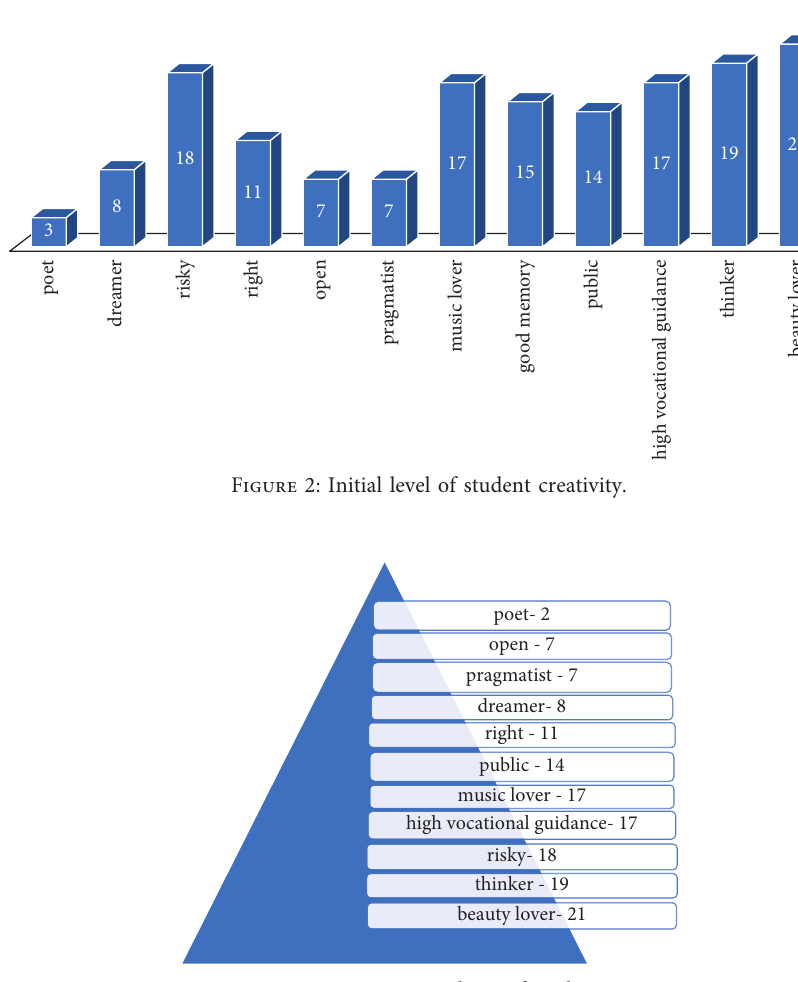
Figure 3: Creative qualities of students.